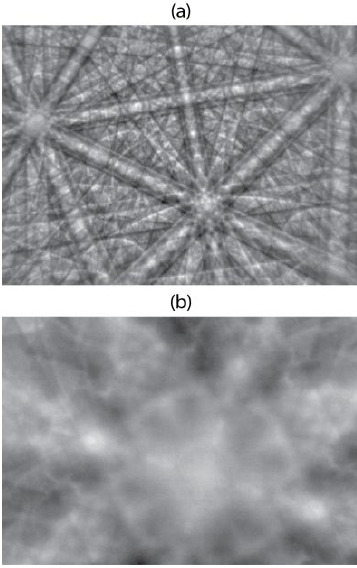
Figure 2. Typical pseudo-Kikuchi pattern obtained in a scanning electron microscope with ( a ) the electron backscattered diffraction (EBSP) technique and ( b ) the electron channeling technique (ECP) on a (001) oriented LaAlO 3 single crystal. Accelerating voltage was 20 kV in ( a ) and 30 kV in ( b ). Note the level of detail available in the (001) zone axis displayed in ( b ). SINGLE COLUMN.